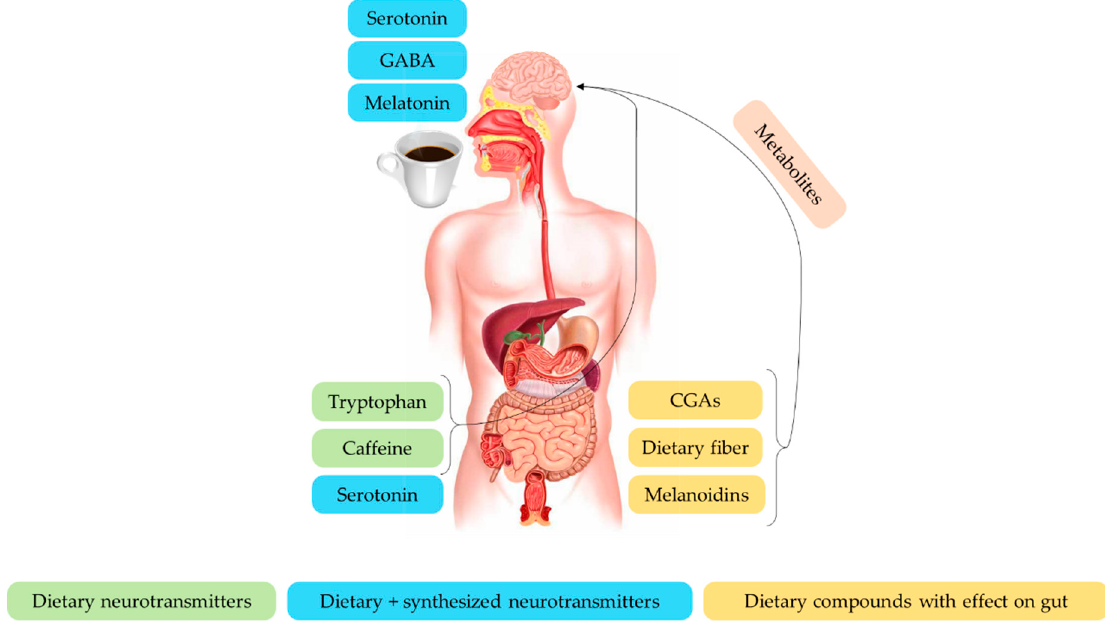
Figure 4. Effect of coffee compounds on the brain–gut axis. Abbreviations: CGAs, chlorogenic acids; GABA, γ -amino butyric acid.